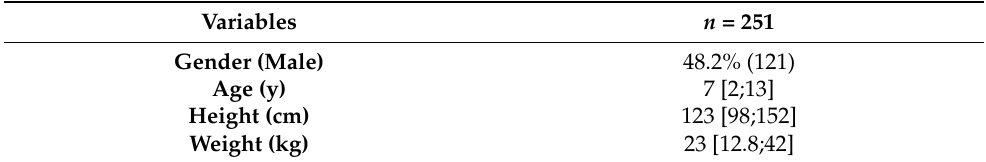
Table 1. Subject characteristics. Data are presented as the median (I, III quartile) for continuous variables and as percentages (absolute numbers) for categorical data.